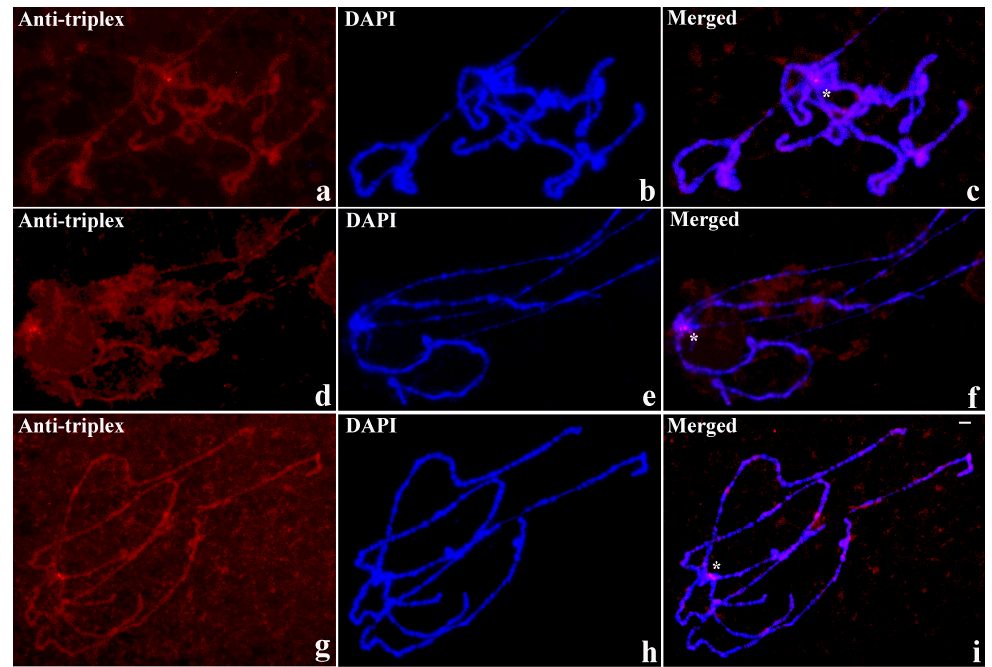
Figure 5. Anti-triplex DNA detection in polytene chromosomes of D. melanogaster from y ( a – c ), w ( d – f ) and y/w ( g – i ) mutants. Antibody labelling ( a , d , g , Anti-triplex), DAPI staining ( b , e , h , DAPI) and the corresponding merged signals ( c , f , i , Merged). Anti-triplex signals are restricted to the pericentric heterochromatin (close to the asterisks). Scale bar corresponds to 25 m.